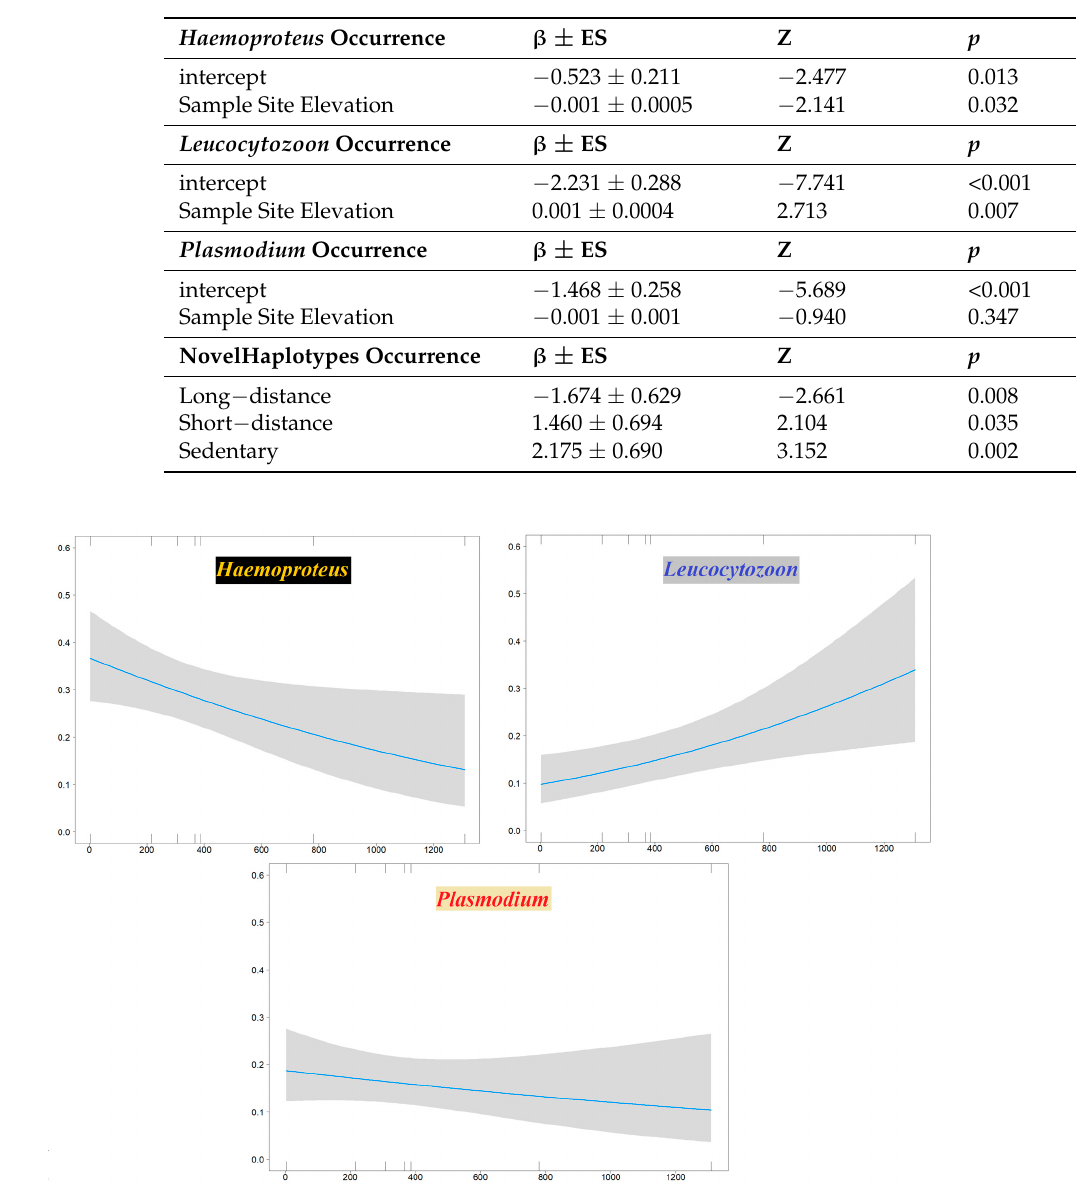
Table 3. Binomial generalized linear models (GLMs) results. The first three (each parasite genus) assess the effects of sample site elevation on haemosporidian occurrence probability, across the entire Sardinian bird community that we sampled. The last result shows the influence of species migratory pattern in affecting novel Sardinian haplotype occurrence probability in infected individuals.